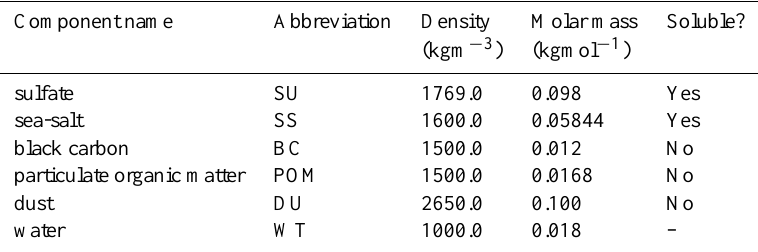
Table 2. Properties of the aerosol components used in the model. Note that although POM is listed as insoluble, an amount of water is associated with POM in soluble modes as described in Sect.